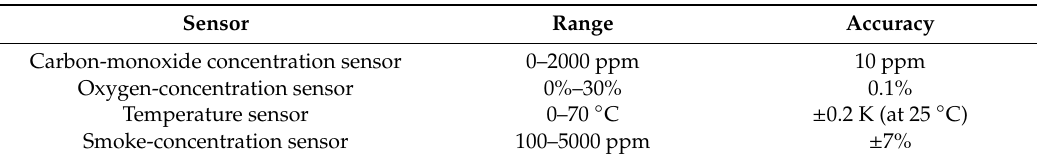
Figure 5. Internal structure of the sensor.